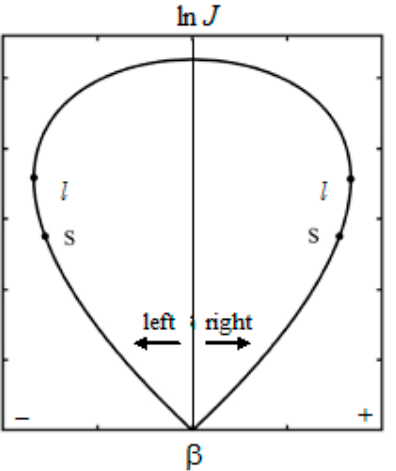
Figure 2. Shock polar (Busemann curve). The point l corresponds to the shock with the maximum possible flow turning angle, and the point s is the sonic point